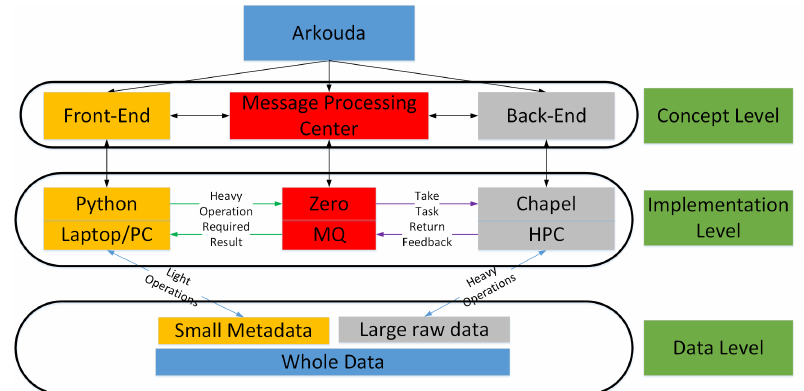
Figure 1. Overview of Arkouda’s components and working mechanism.